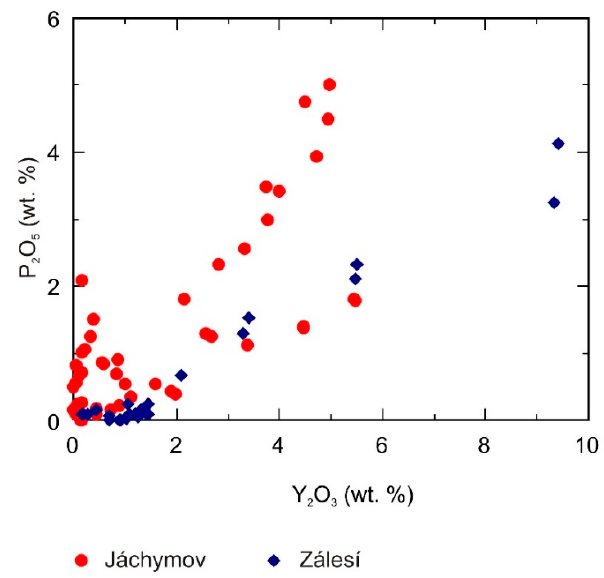
Figure 14. Distribution of P and Y in coffinite from the J á chymov uranium district and the Z á les í uranium deposit.